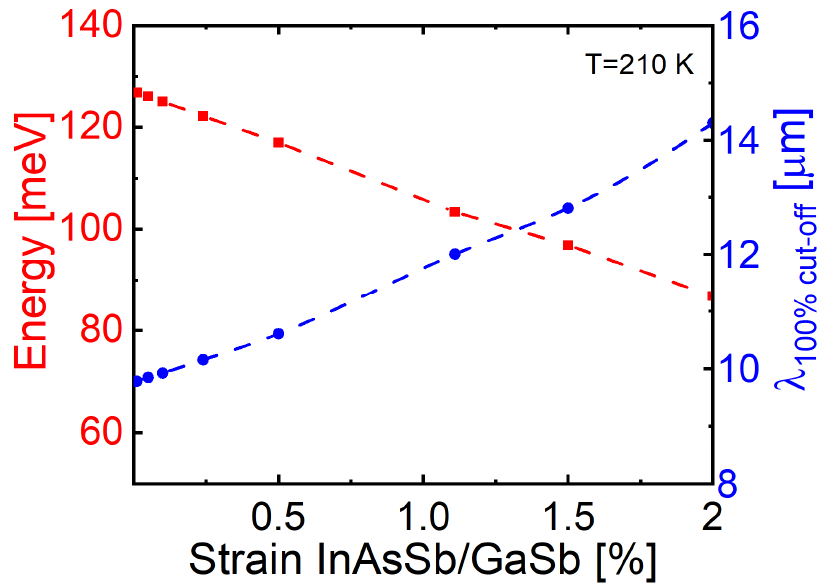
Figure 8. T2SLs’ InAs/InAsSb bandgap and λ 100%cut-off for Set I samples 4, 5, and 6 versus strain in InAsSb layer (in-plane strain in relation to the GaSb).